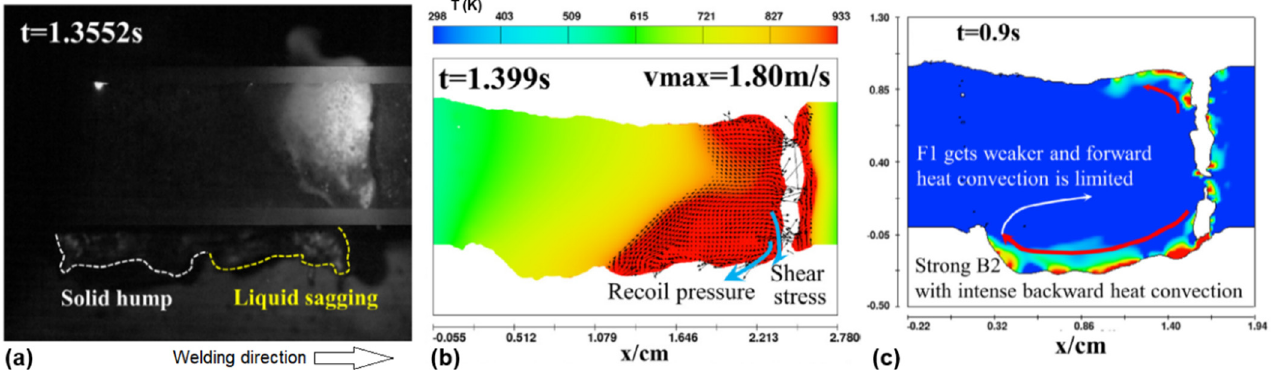
Figure 22. Formation of humping in root in case of 10 mm AA5083: ( a ) image taken in situ by observation through glass; ( b ) numerical simulation of hump formation; and ( c ) thermal fluid behaviour (F1 is forward melt flow and B2 is backward melt flow). Longitudinal weld sideview. After [88].